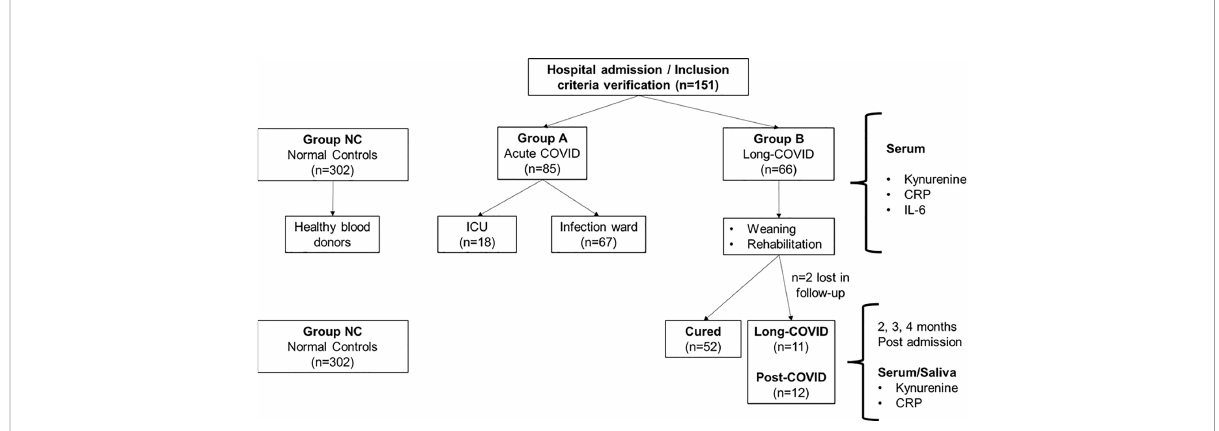
FIGURE 1 Overview of the different study populations and the respective experimental biomarkers. Group NC (normal controls) consisted of healthy blood donors (30, 31) where kynurenine concentrations were measured and taken as reference values for the Sars-CoV-2 infected individuals (Group A and Group B). ICU = Intensive Care Unit; CRP = C-Reactive Protein; IL-6 = Interleukin